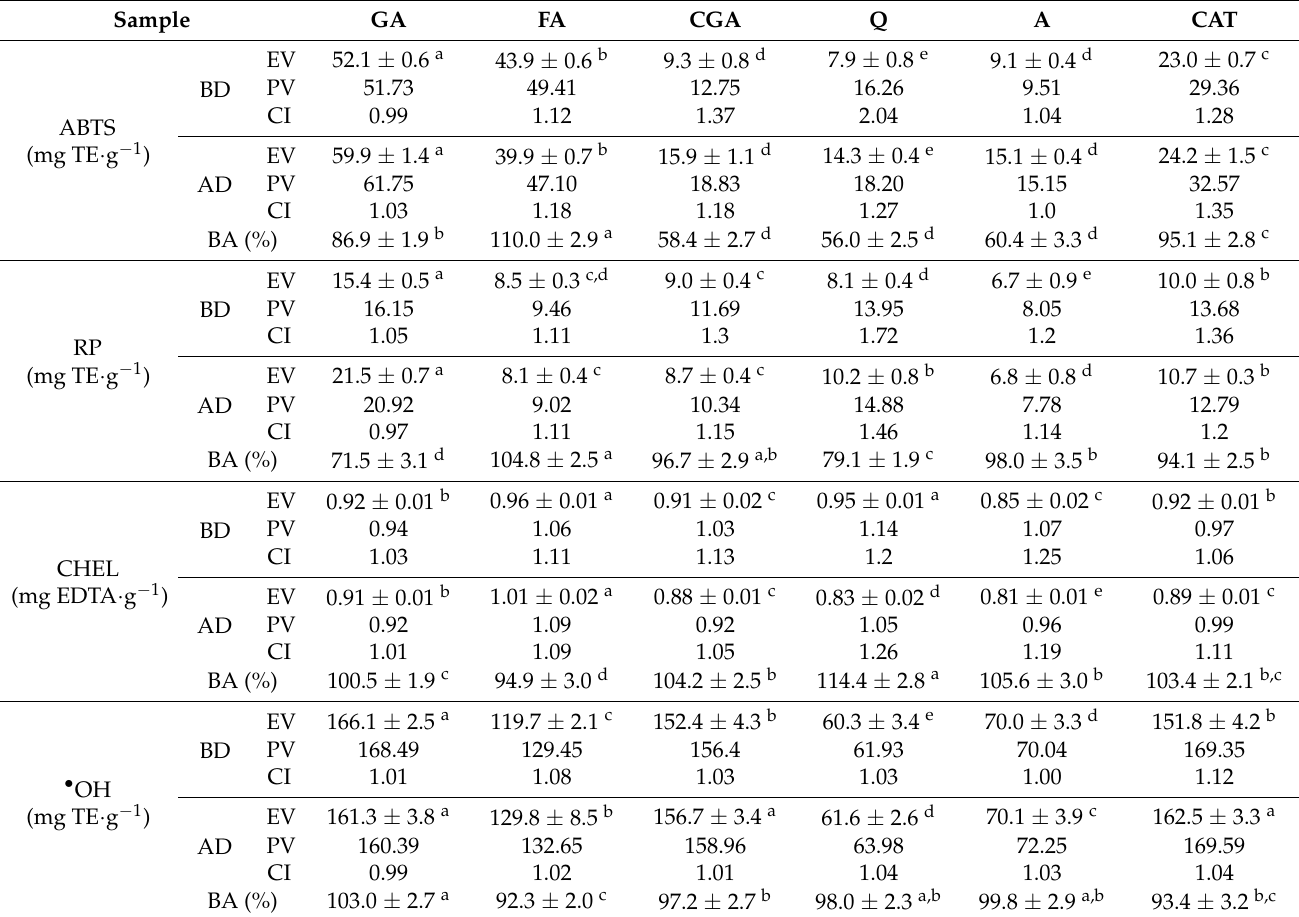
Table 2. Effect of food matrix on antioxidant activity of fortified white bean paste. Sample